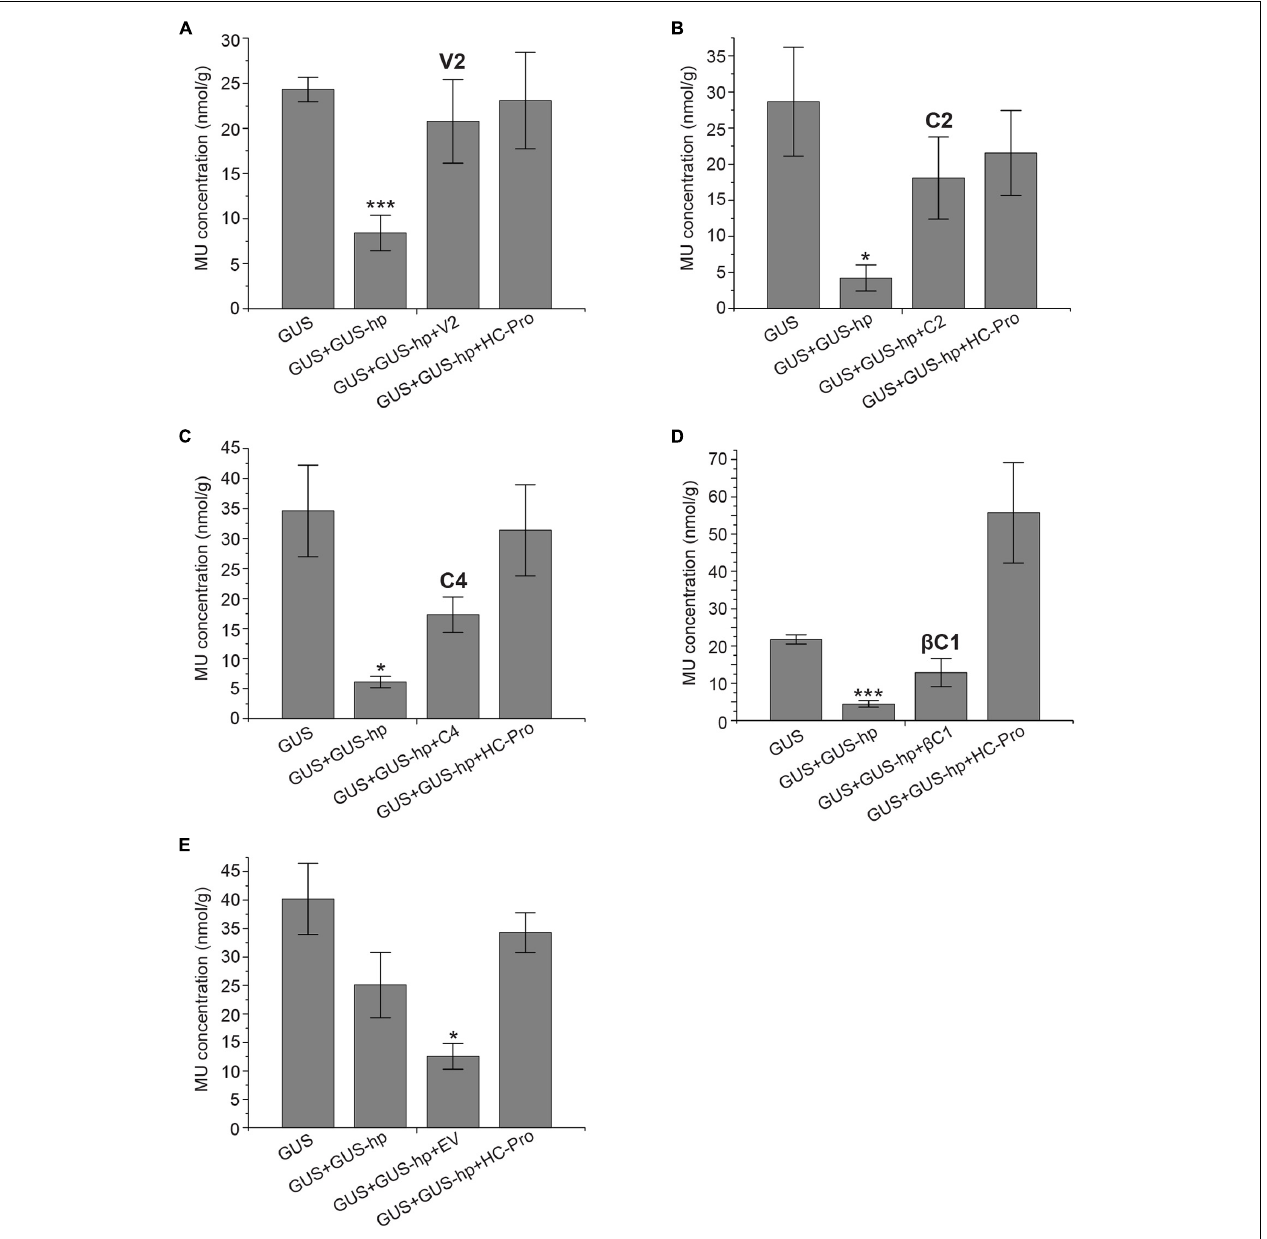
FIGURE 2 | GUS quantification (MUG) assays confirm the silencing suppressor function of CYVMV V2 (A) , C2 (B) , C4 (C) , and β C1 (D) . HC-Pro was used as a positive control. EV was used as a negative control (E) . MU concentrations were presented as nmol per gram of leaf tissue (nmol/g). Each data point includes three biological replicates. Error bars denote standard error. Student’s t -test was used to determine the significance of differences. * P < 0.05 and *** P < 0.001.